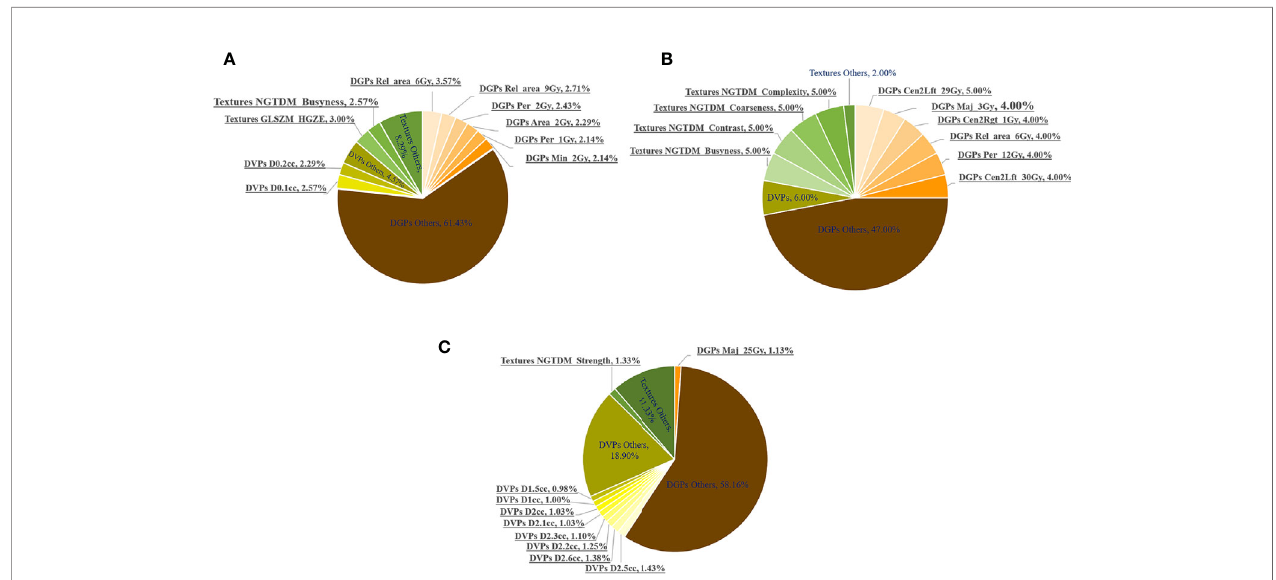
FIGURE 5 | Number of times (%) the dosimetric features were selected as top 20 features in the fi vefold cross-validation of all the discriminative models with AUCs >0.80. The most frequent 10 features are underlined. Number of times (%) being selected as the Top-20 features in the (A) whole, (B) anterior and (C) posterior rectal surface